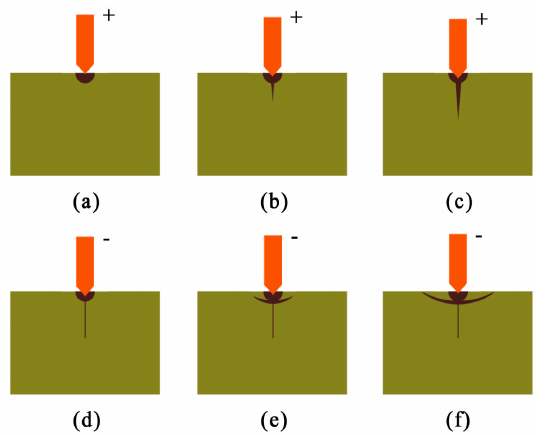
Figure 1. Microfracture model for brittle materials: ( a ) Initial loading; ( b ) Critical zone formation; ( c ) Stable crack growth; ( d ) Initial unloading; ( e ) Residual-stress cracking; ( f ) Complete